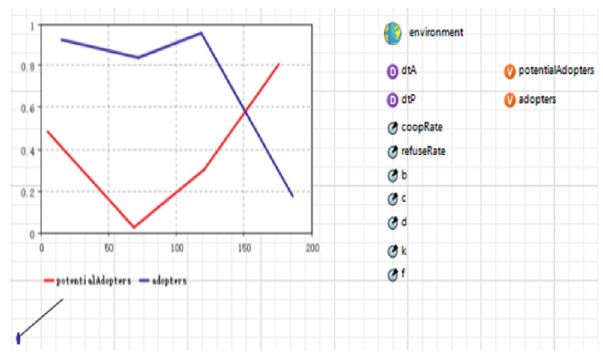
Figure 6: Main model.